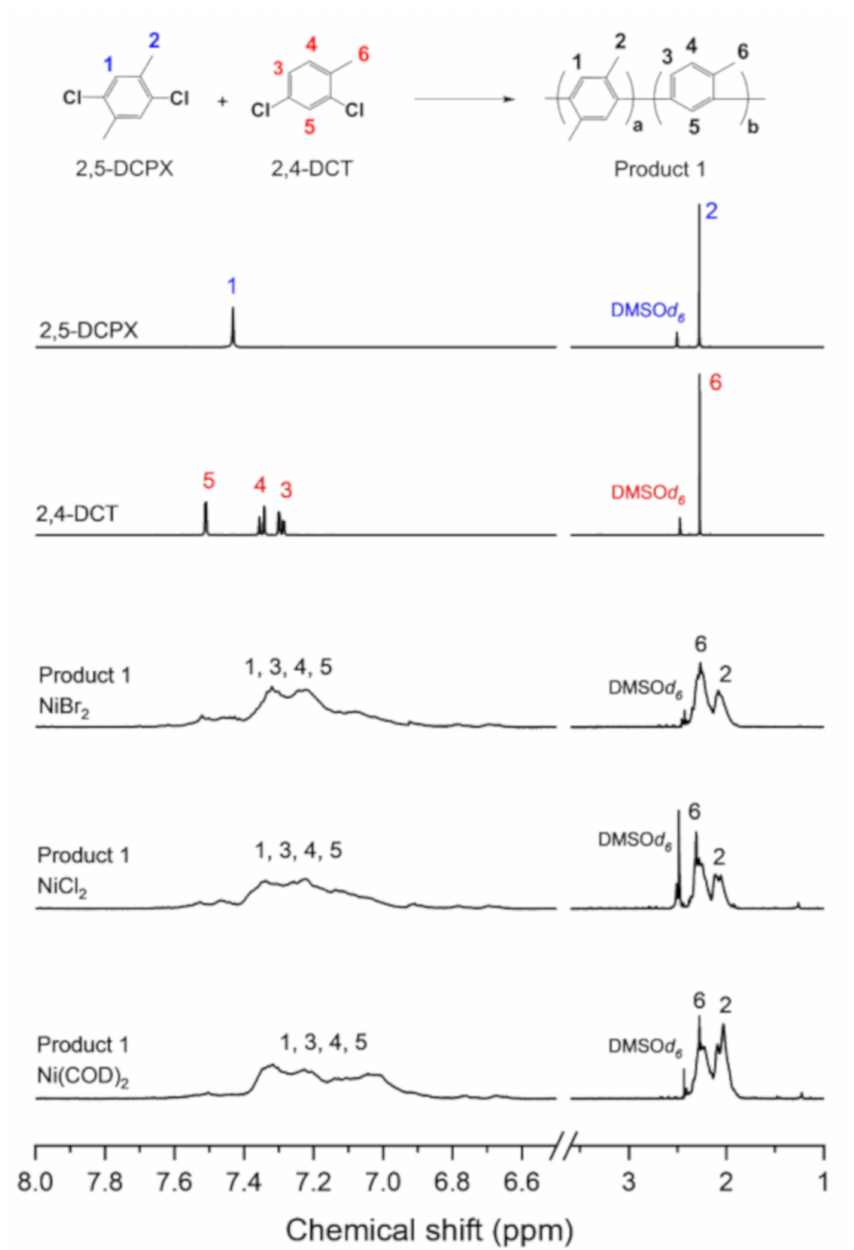
Figure 2. 1 H NMR spectra of 2,5-dichloro -p- xylene (2,5-DCPX), 2,4-dichlorotoluene (2,4-DCT), and Product 1 synthesized using NiBr 2 , NiCl 2 , or Ni(COD) 2